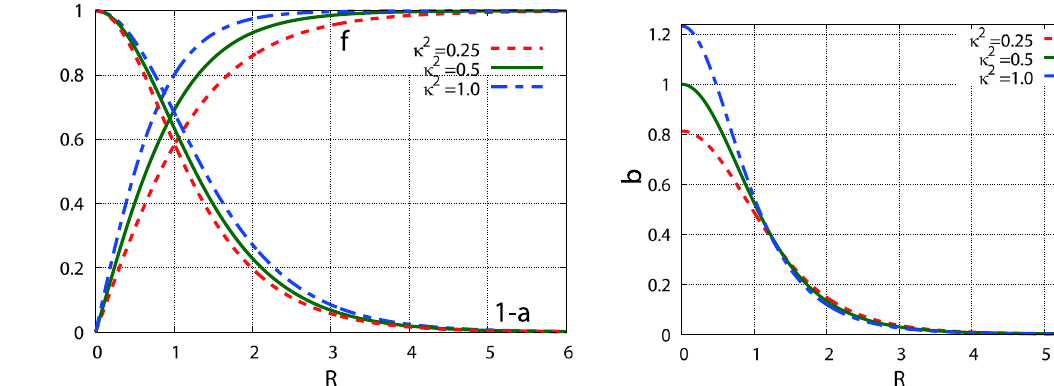
sponding dimensionless magnetic field b defined in (34) as a function of R for various values of κ , κ = 1 number n =